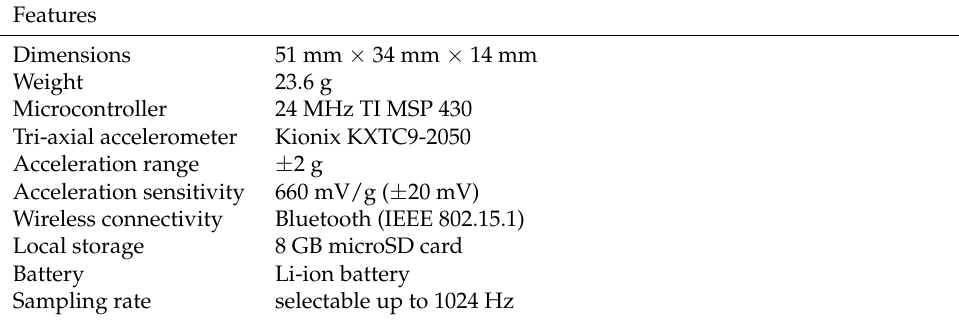
Table 1. Main Features of Shimmer3